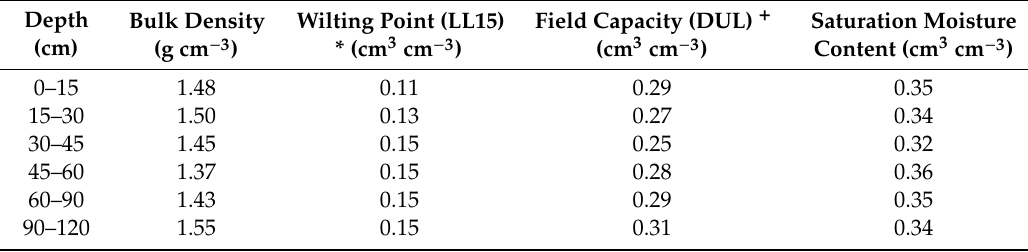
Table 1. Water holding characteristics of the Red Kandosol soil at Wagga Wagga, NSW, Australia (http: // www.apsim.info / ).